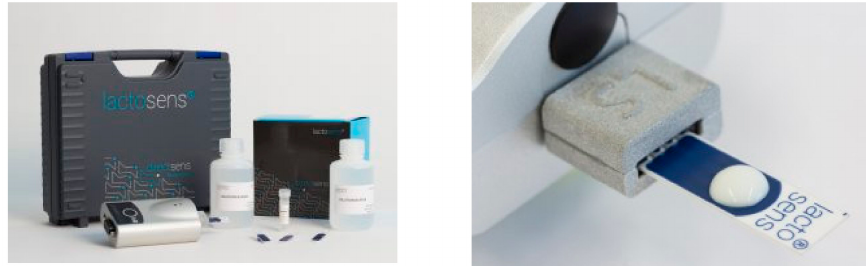
Figure 9. LactoSens ® enzymatic biosensor for lactose detection in milk. Reproduced with permission from DirectSens ® (Directsens, Klosterneuburg, Ausria)